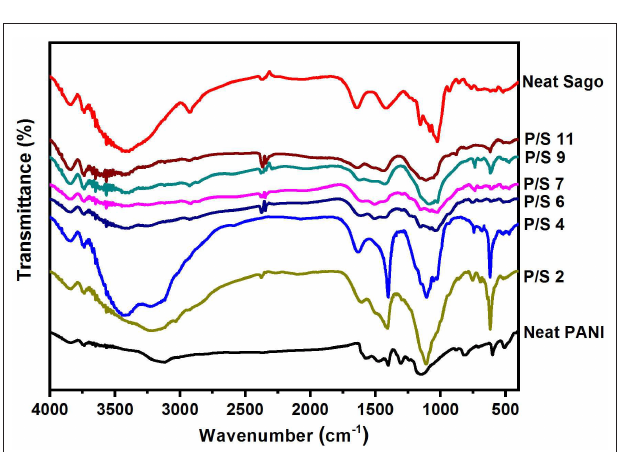
FIGURE 5 | FT-IR spectrums of PANI, Sago and PANI/Sago blends of varying